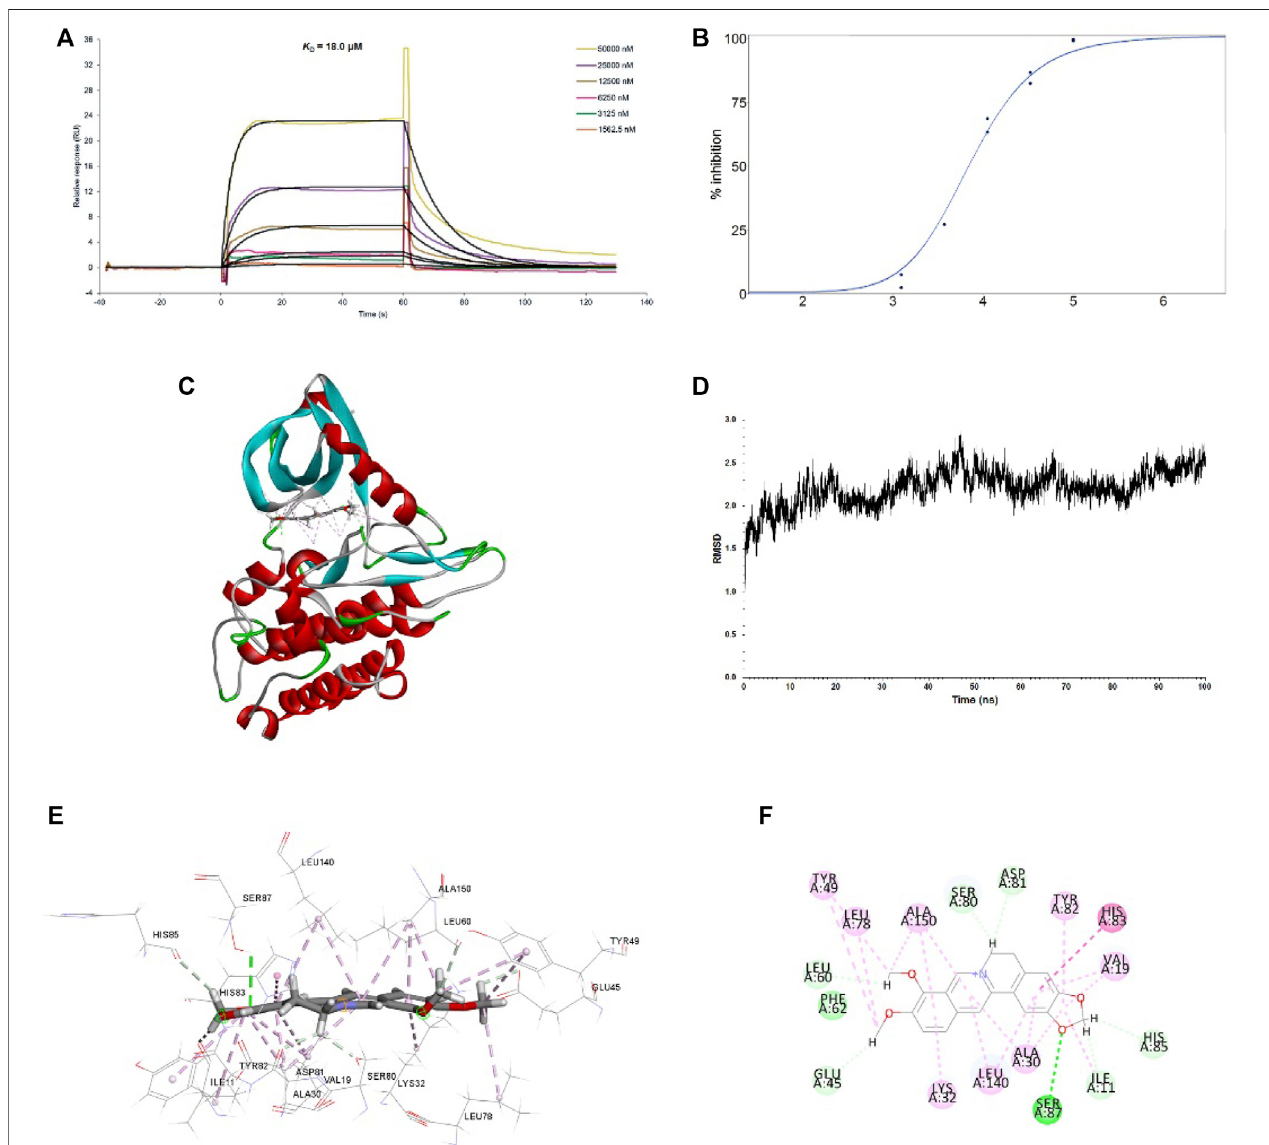
FIGURE 5 | Interactions between BBR and TGFBR1 (A) . Binding af fi nity of BBR to TGFBR1. The binding curves were analyzed using a kinetic analysis supplied with Biacore Evaluation Software. Data are presented as RU over time (s). The K D were calculated using a 1:1 binding model (B) . Inhibition of BBR on TGFBR1 kinase activity.Thedose-response curve forIC 50 valuewasdeterminedbynonlinear regression (C) .Binding featureofBBRwithTGFBR1. BBRand keyresidues areshown as sticks with carbon (gray), oxygen (red), and nitrogen (blue). Electrostatic interaction is shown as dashed lines with π - π (purple), π -alkyl (pink), and hydrogen bonds (green). Secondary structural elements are depicted as ribbons (coils, α -helices; arrows, β -sheets). Color is based on secondary structures ( α -helices, red; β -sheets, blue; loops, green) (D) . molecular dynamics (MD) simulation of BBR in complex with TGFBR1. The selected pose was subjected to 100 ns MD simulations using a standardized MD protocol through PP. Stability was analyzed by root mean square deviation (RMSD) vs. time (ns) (E) . Molecular interaction of BBR with TGFBR1 residues (shown in sticks and labeled in black) (F) . Molecular interaction schemes of BBR with TGFBR1 residues.